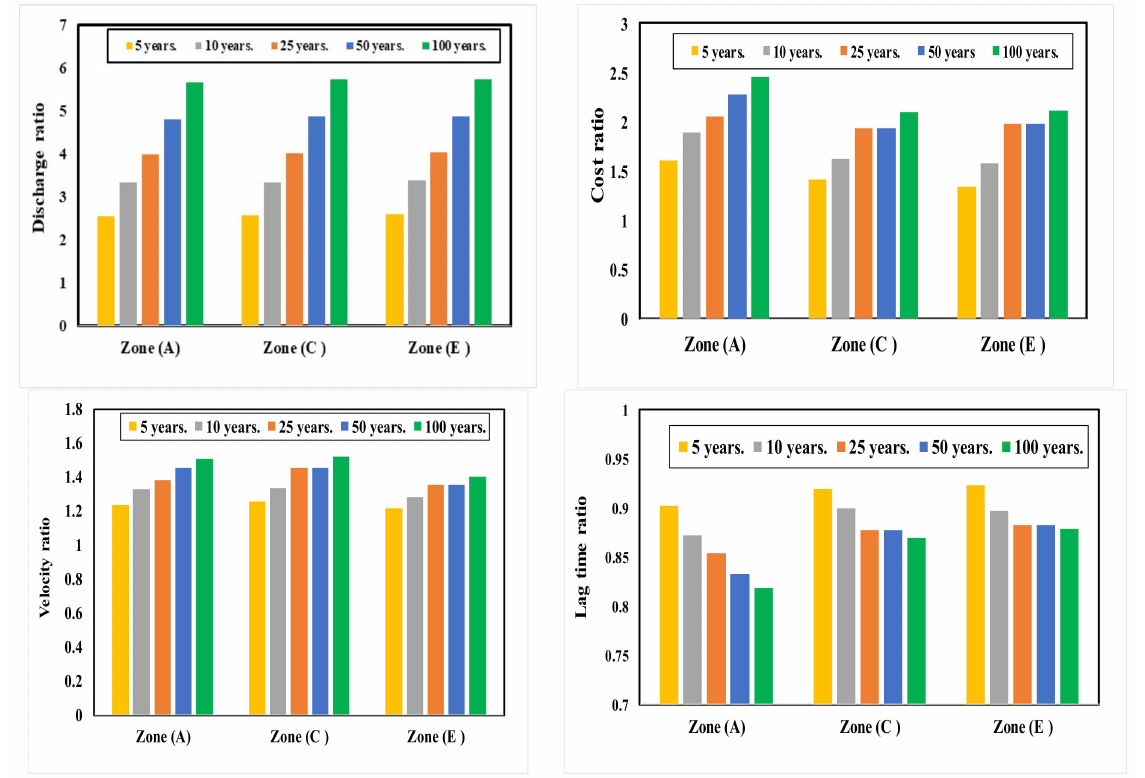
Figure 12. Comparison between discharges, cost, velocity and lag time for zones A, C and E at runo ff coe ffi cient (C =